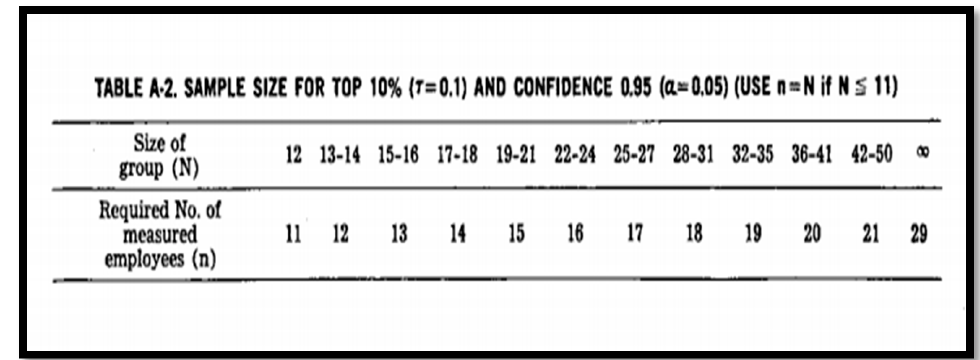
Figure 2. Sample size of the personal air sampling “for a maximum risk subgroup from a homogenous high − risk group” (NIOSH,